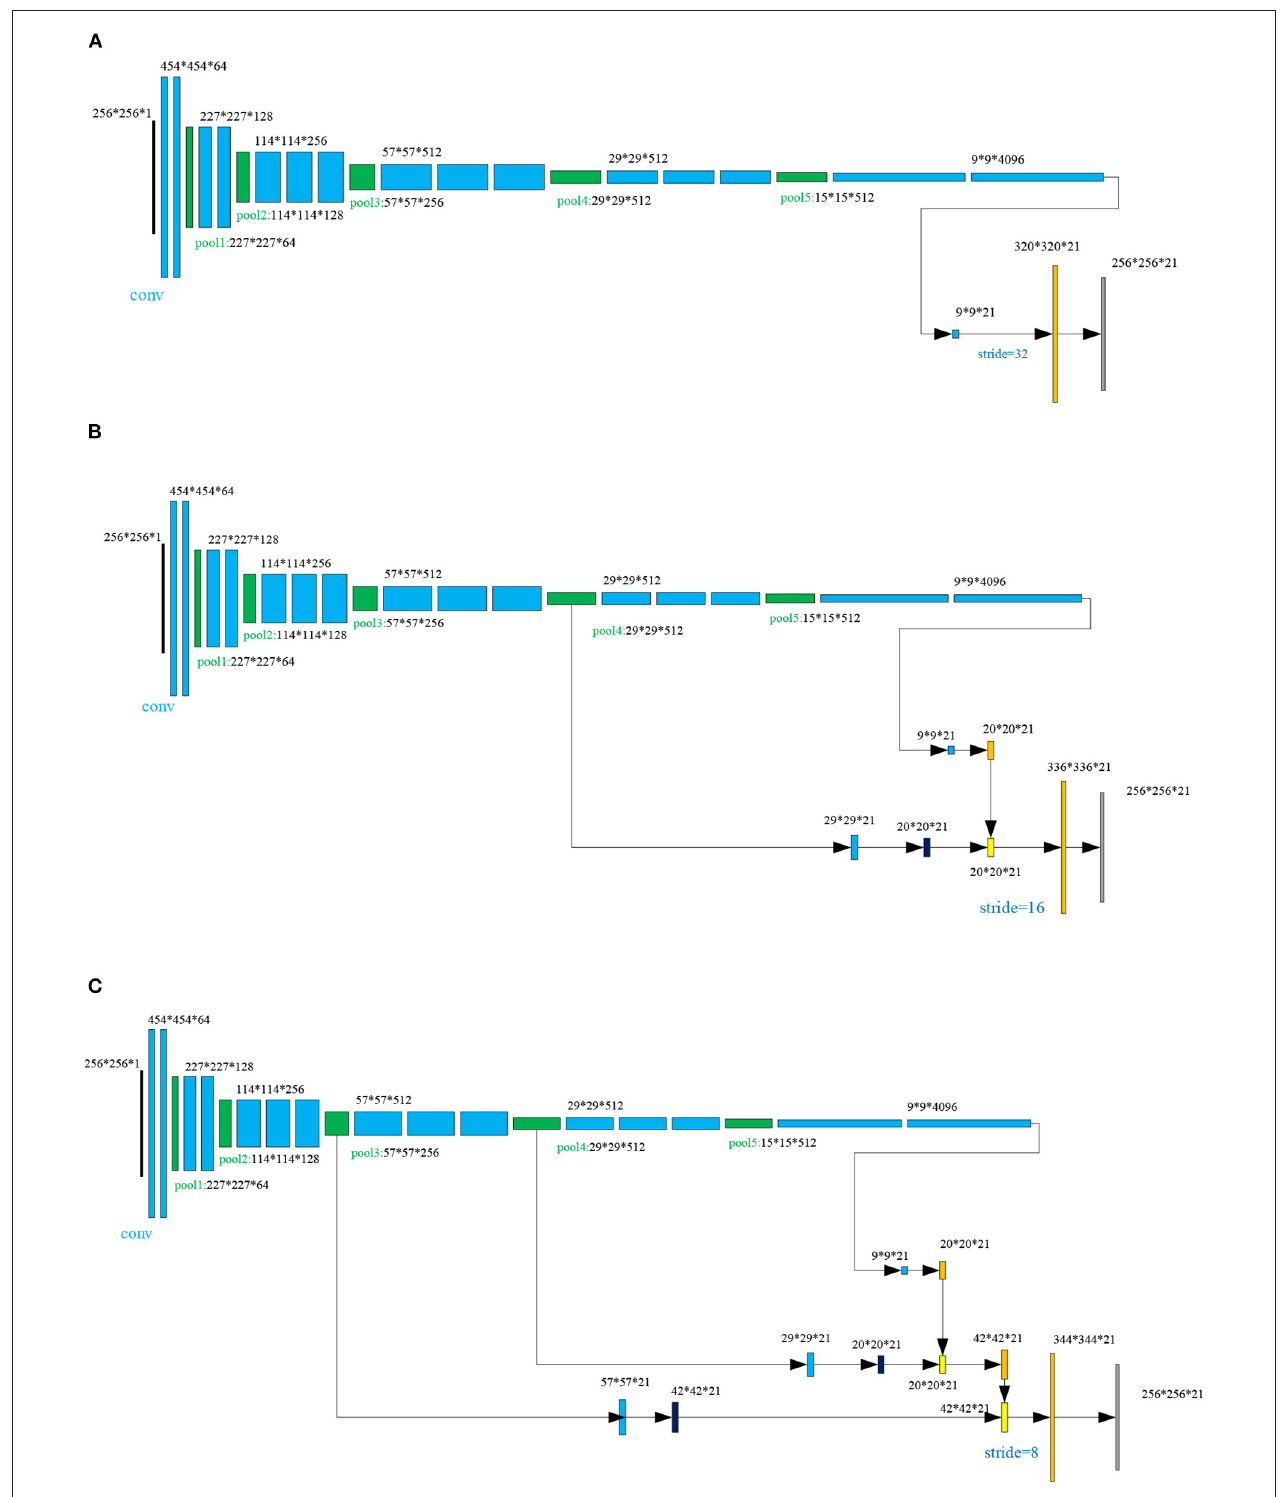
FIGURE 3 | The skip architecture for upsampling for three scenarios: (A) FNC-32s, (B) FNC-16s, and (C) FNC-8s.